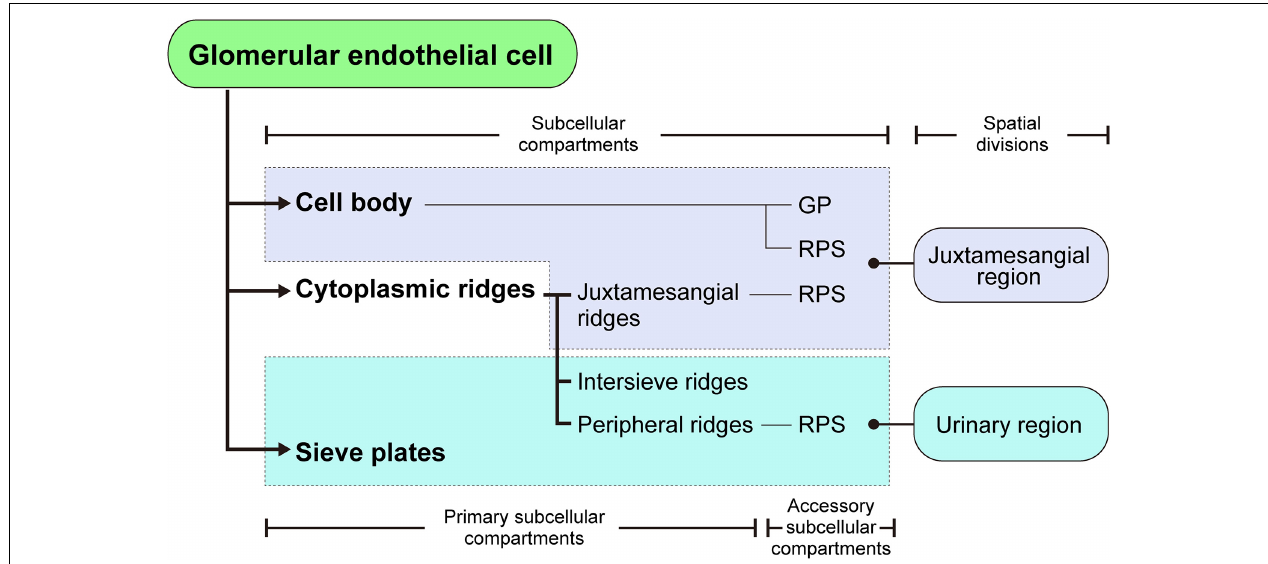
FIGURE 8 | Structural hierarchy of the subcellular compartments in a glomerular endothelial cell (GEnC). The reticular porous structures (RPSs) are formed on the cell body, juxtamesangial ridges, and peripheral ridges, with the globular protrusions (GPs) on the cell